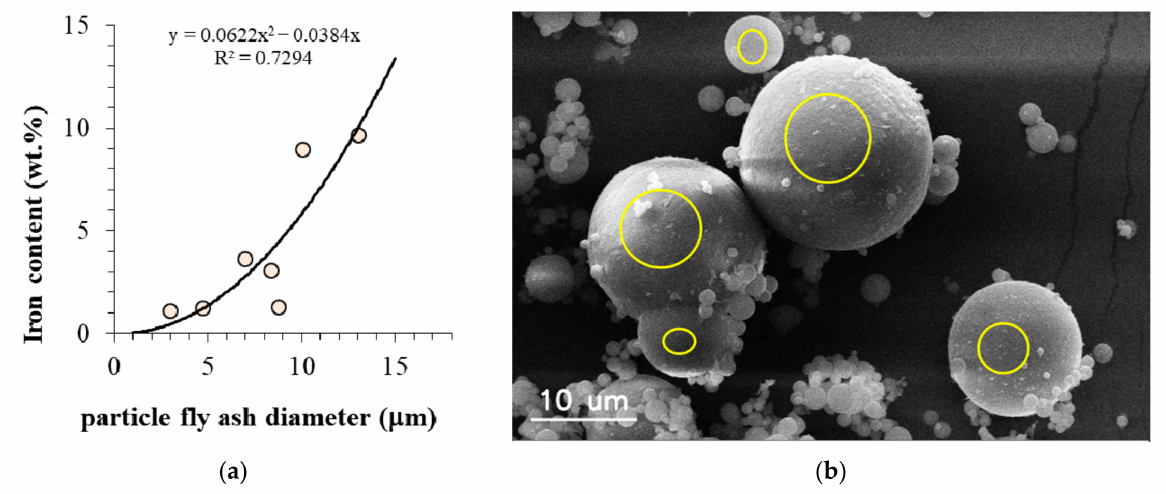
Figure 7. ( a ) The relation between the magnetic particle size and iron content in it; ( b ) SEM micropho- tographs with marked area of EDS spectra acquisition for various